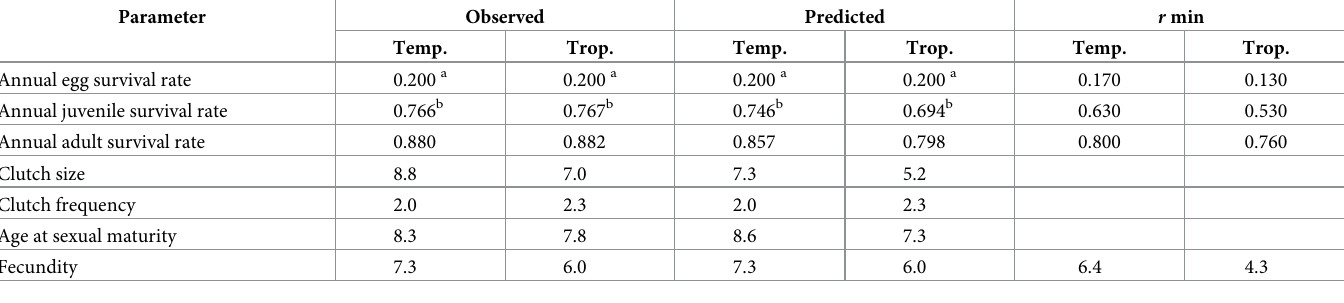
Table 5. Demographic parameters used in population modelling to estimate capacity for sustainable harvest in freshwater turtles. Observed are median values derived from the scientific literature (S1 Table) and predicted values are from the 95% confidence set of GAM models (Table 3). “ r min” are the minimum values necessary to obtain positive intrinsic rate of growth ( r ) as determined via sensitivity analysis (Fig